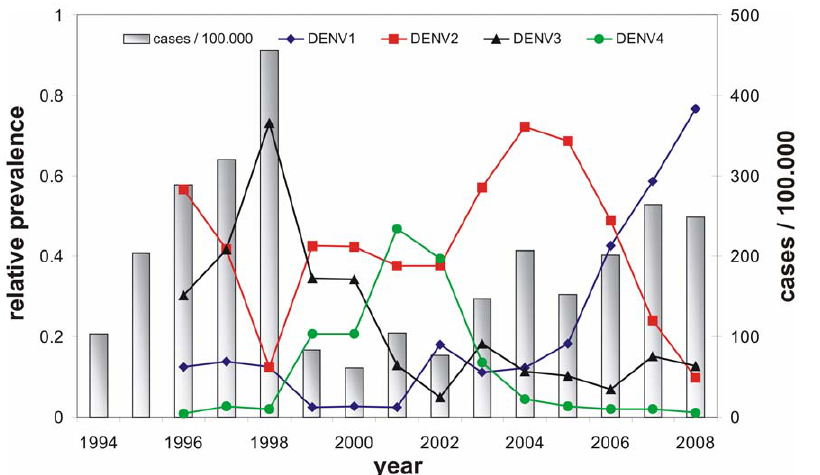
Figure 1. Dengue epidemiology in South Vietnam. The total annual number of dengue cases (blue bars) and relative serotype prevalence (lines) over the period 1994–2008 in the southern 20 provinces of Viet Nam show the characteristic fluctuation in disease incidence and sequential replacements of dominant serotypes. Source of data: Vietnamese Ministry of Health Dengue passive surveillance scheme and kindly provided by the Pasteur Institute, HCMC, Viet Nam. The Hospital for Tropical Diseases is a tertiary referral hospital for infectious diseases.